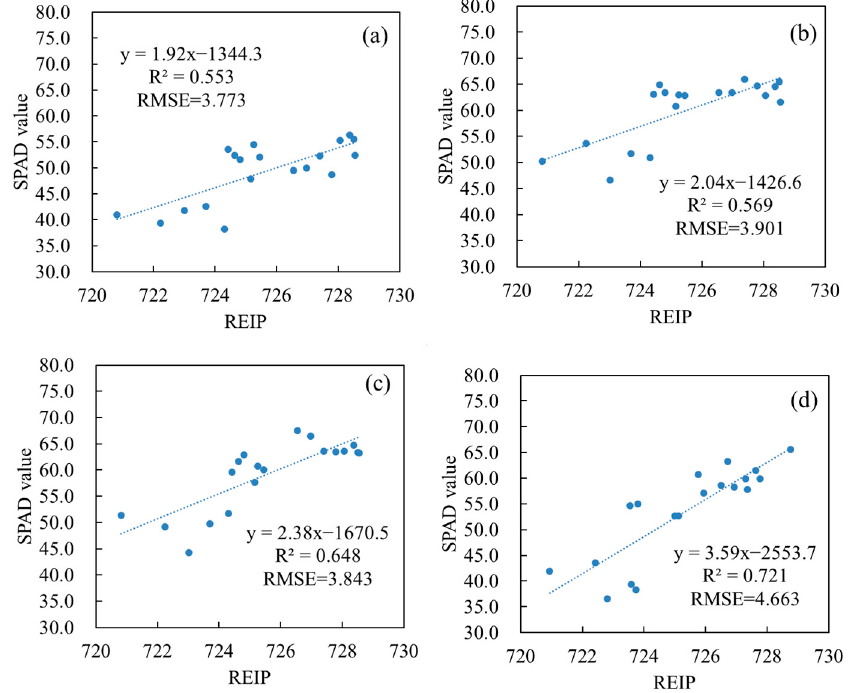
Figure 9. Relationship between SPAD values of different layers and the REIP index under the optimal VZA in the late growth stage: ( a ) 1st layer, ( b ) 2nd layer, ( c ) 3rd layer, and ( d ) 4th layer. Table 5. Accuracy evaluation